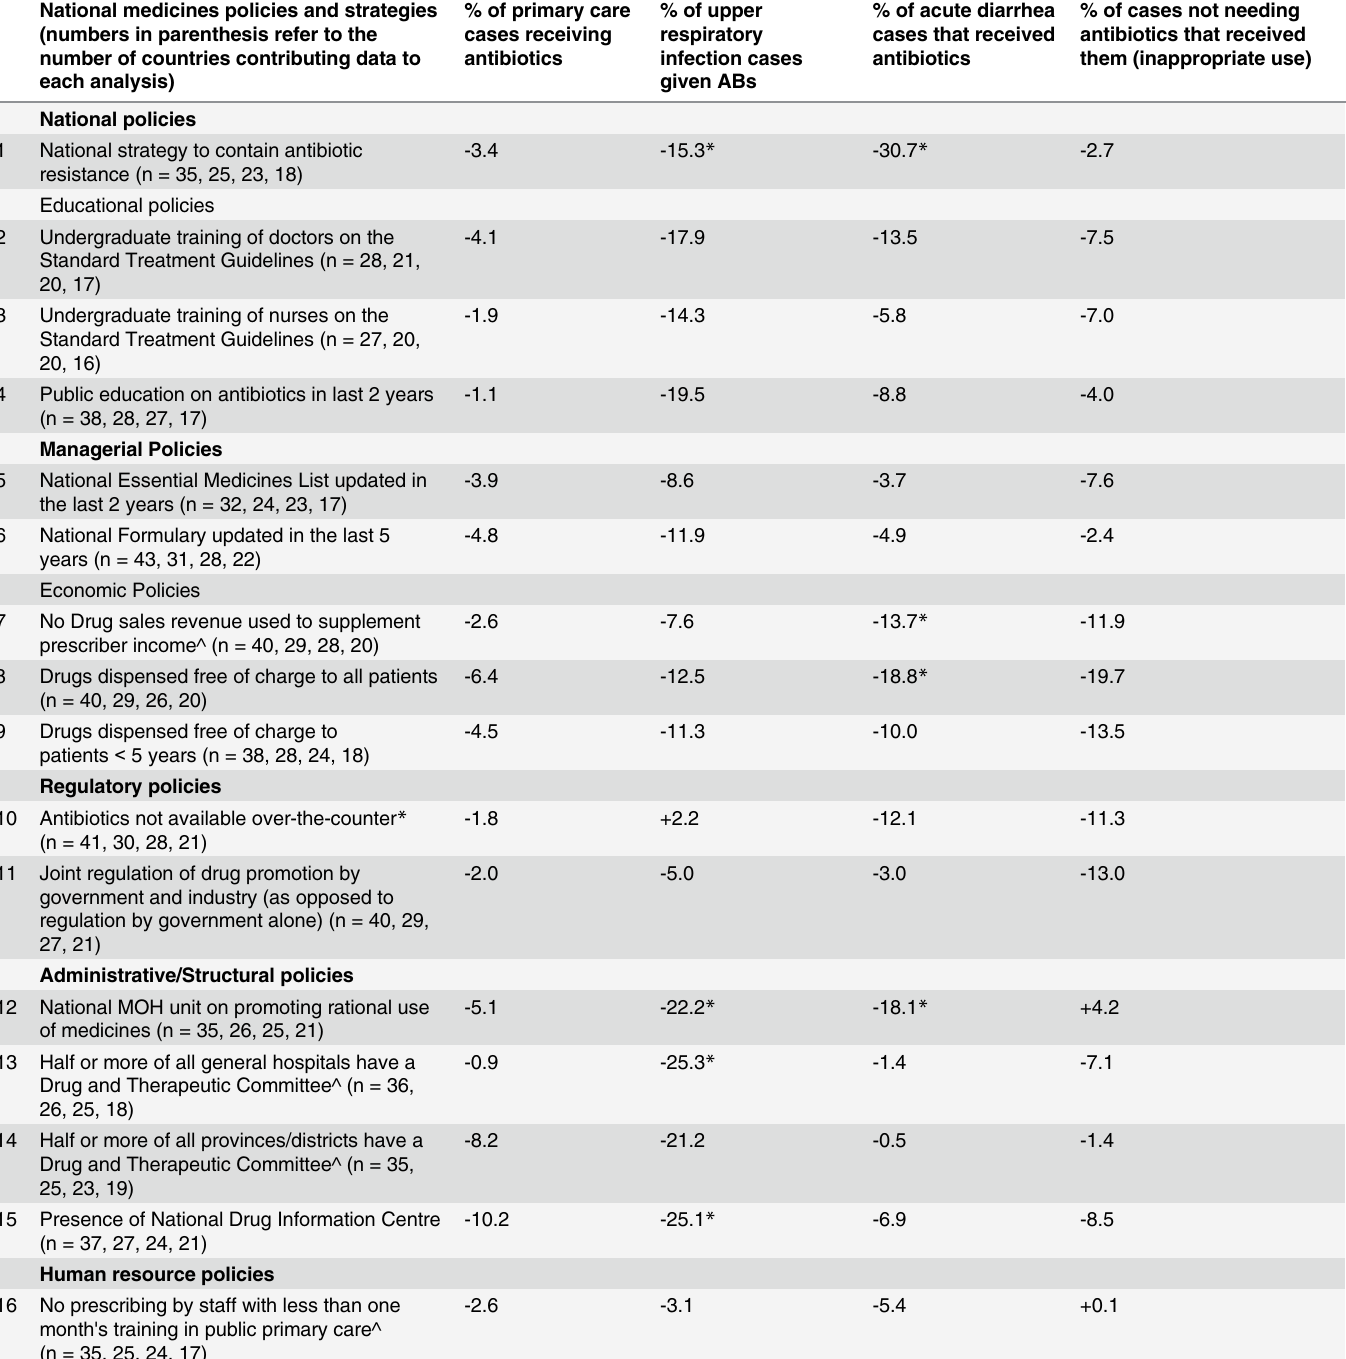
Table 1. Differences in antibiotic use between countries with and without each of 16 policies hypothesized to decrease inappropriate antibiotic use. National medicines policies and strategies (numbers in parenthesis refer to the number of countries contributing data to each